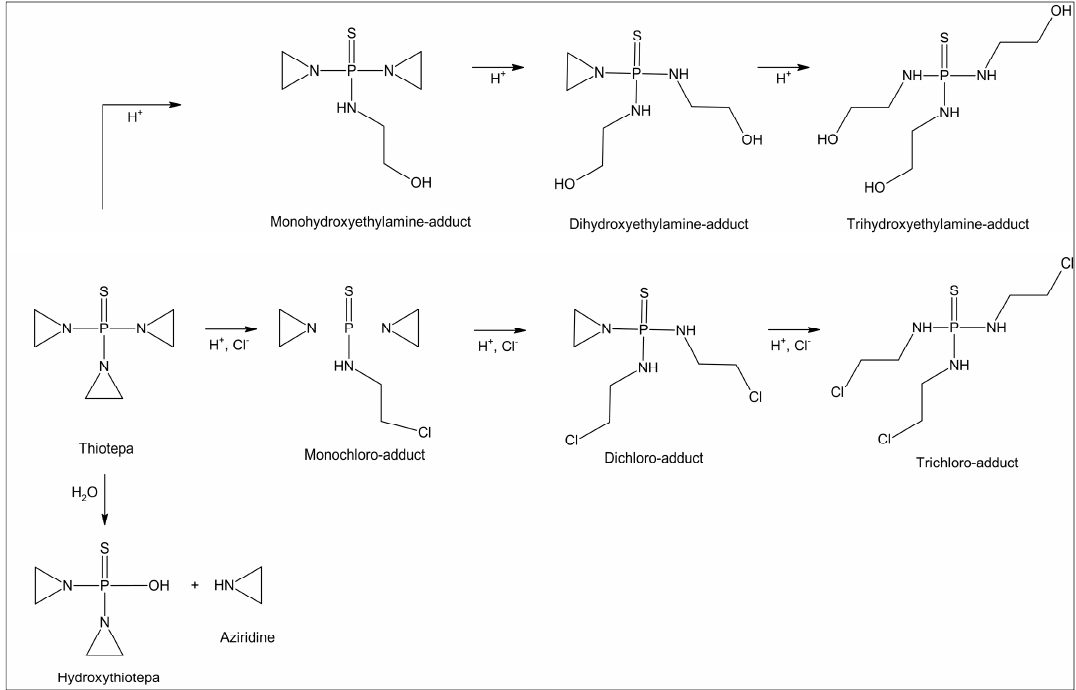
Figure 1. Degradation scheme of thiotepa in the absence and presence of sodium chloride, adapted from van Maanen et al. [7].